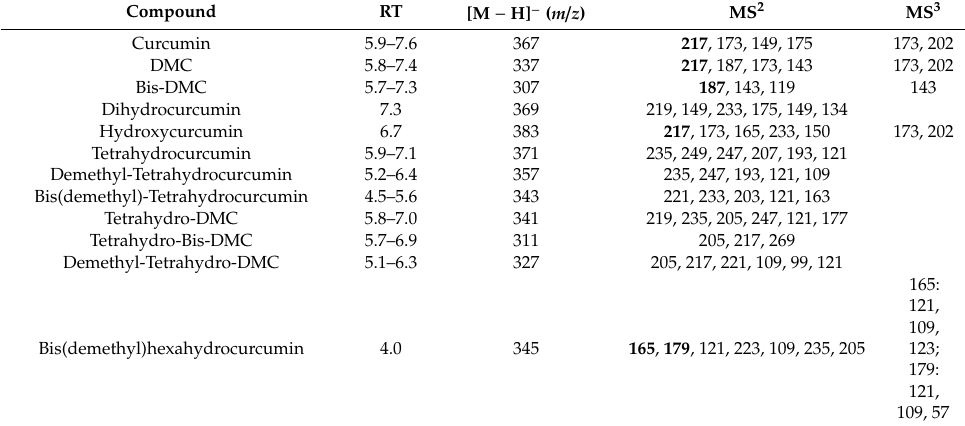
Table 2. Mass spectrometric and chromatographic characteristics of parent curcuminoids and their fecal metabolites identified in curcumin botanical extracts and in fecal fermented